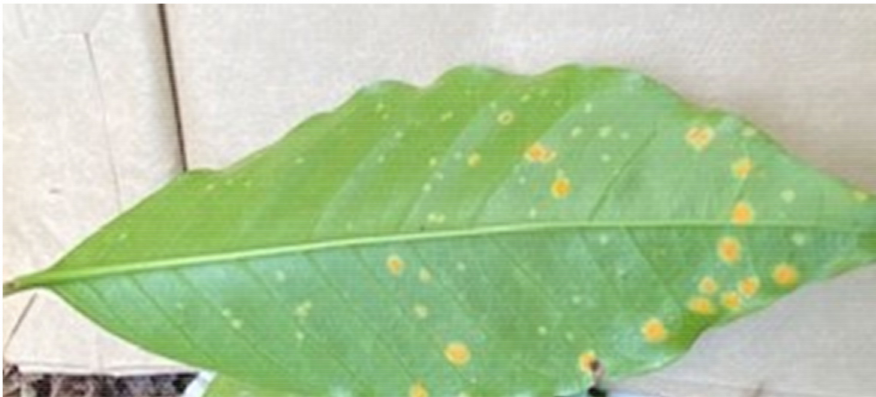
Figure 1. Young orange to yellow lesions of Coffee Leaf Rust on the underside of a coffee leaf.